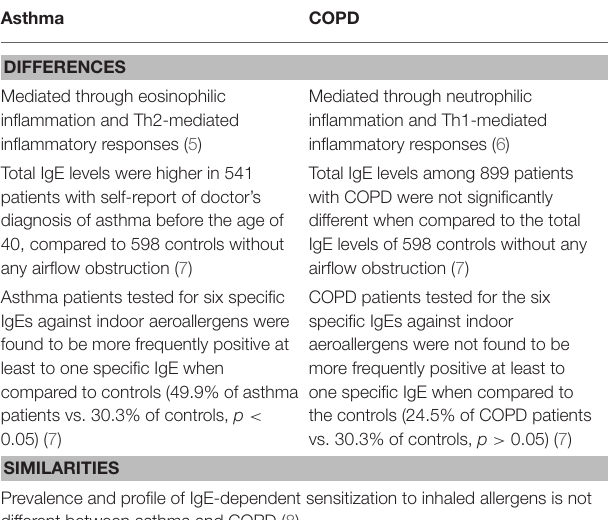
TABLE 1 | Comparison of IgE production and the allergic profile in asthma and COPD patients. Asthma